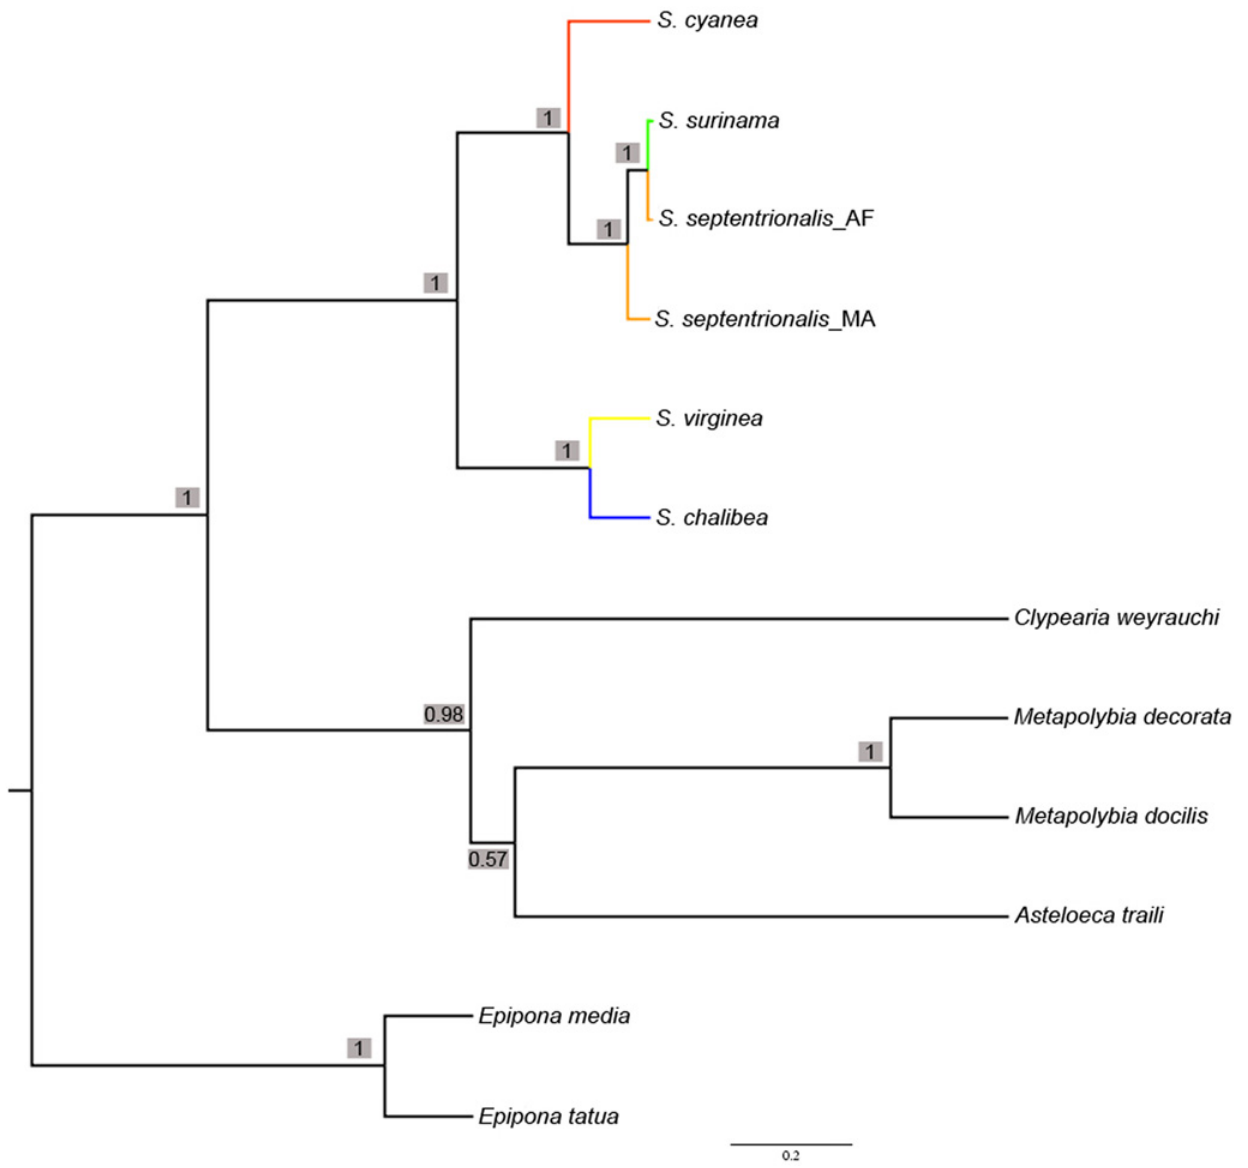
Fig 4. Species tree generated by * BEAST. Bayesian posterior probabilities indicated above or below branches. Branch colors follow Fig. 3.